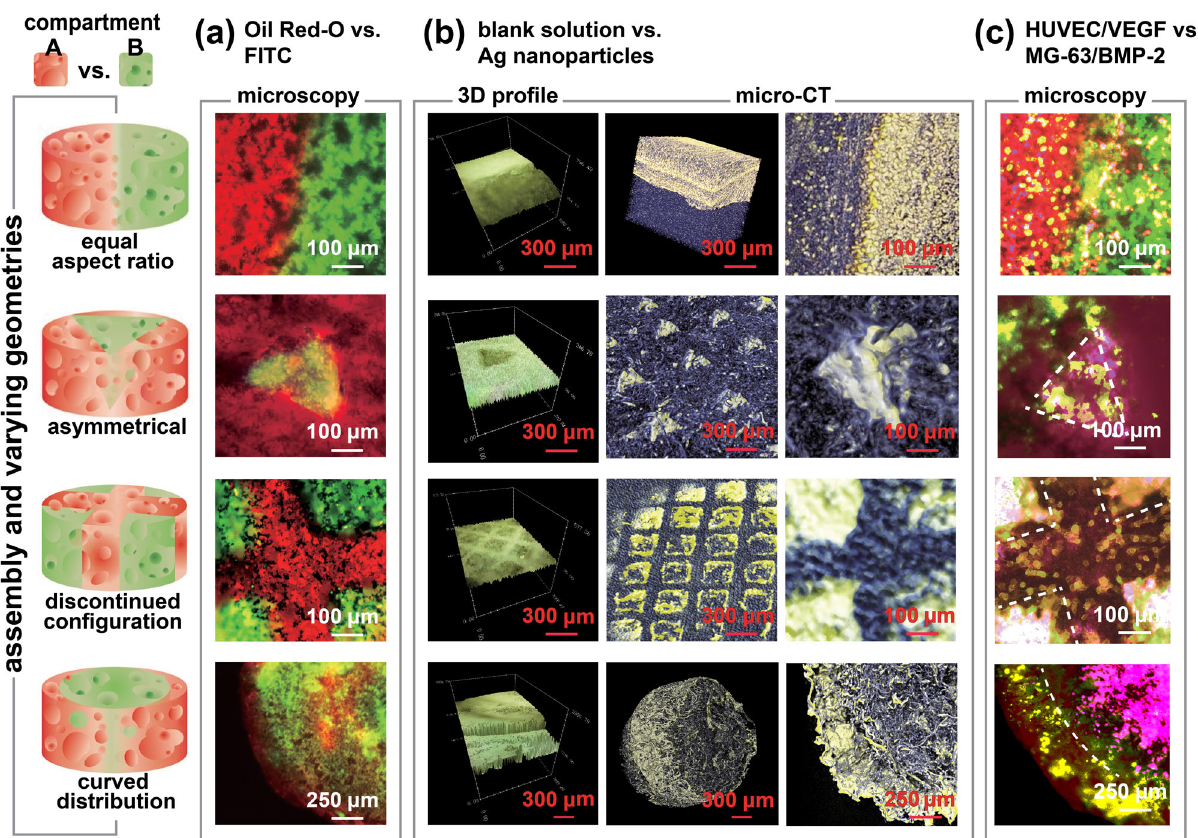
Fig. 3 Assembly of various modules with de fi ned chemical/biological components and geometric architecture into one modulated construct with different compartments A vs. B. Components used for assembly and fabrication of the two compartments included a Oil Red-O (red channel) vs. fl uorescein-5-isothiocyanate (green channel), b blank solution vs. silver (Ag, yellow) nanoparticles in 3D-pro fi led images and tomographic images, and c co-cultured system HUVECs combined with VEGF vs. MG-63 and BMP-2. The geometric illustration of the assembly and fabrication is shown on the left indicating equal aspect ratio, asymmetrical, discontinued con fi guration, and curved distribution of the two compartments. Each experiment was repeated three times independently ( n = 3) with similar